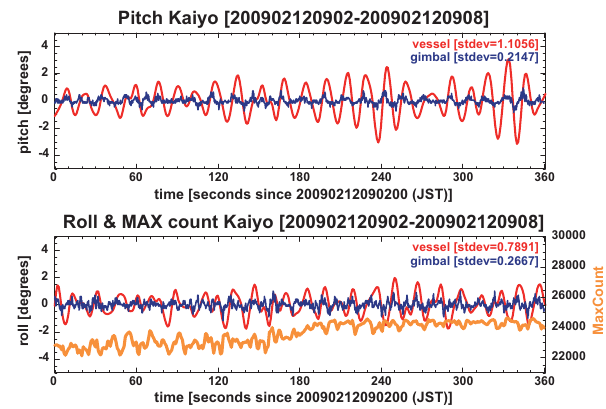
Fig. 3. Example of pitch (top) and roll (bottom) angles recorded for the vessel (red line) and the active gimbal (blue line). The yel- low line indicates the maximum count of the spectrum. At approxi- mately 180 seconds, the viewing elevation angle was changed from 3 ◦ to 5 ◦